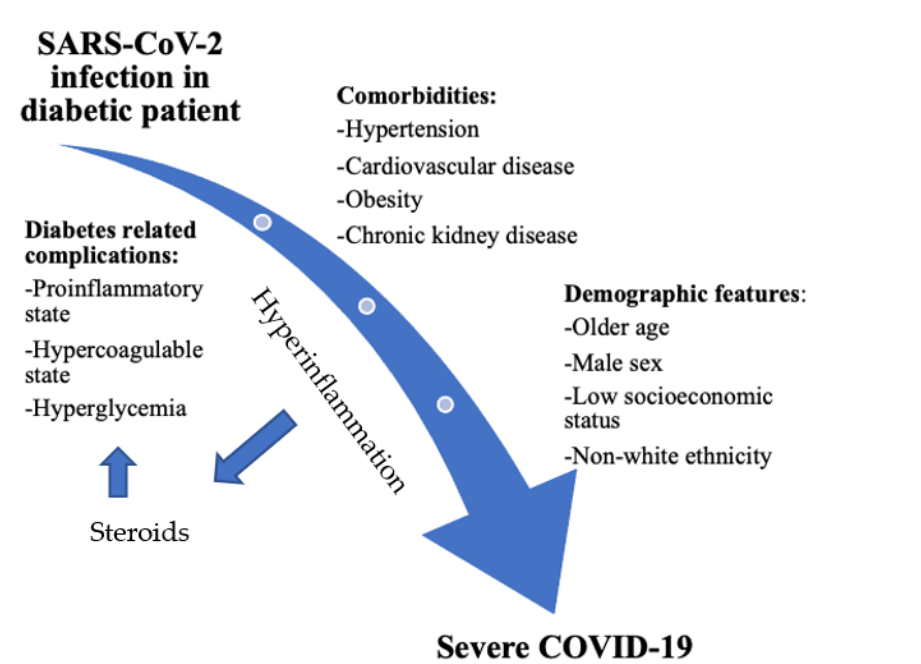
Figure 2. The relationship between SARS-CoV-2 infection, COVID-19 and diabetes. In a diabetic patient, the presence of diabetes-related complications, associated comorbidities and certain demographic features may worsen the prognosis. Hyperglycemia is a strong risk factor for a severe course of COVID-19. Hyperinflammation associated with severe COVID-19 treated with steroids can worsen hyperglycemia.